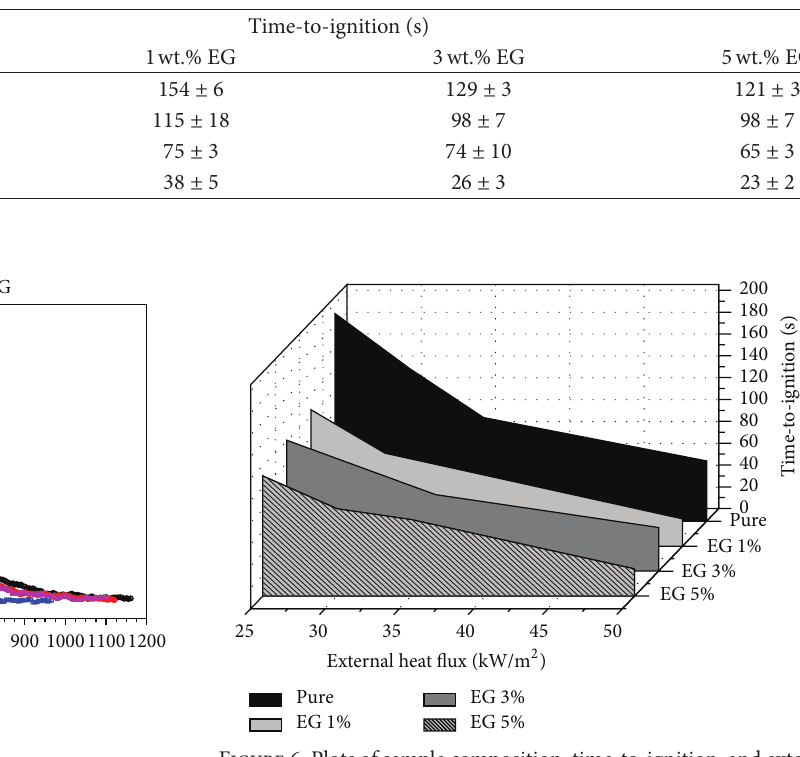
Figure 4: HRR profile epoxy-3 wt.% EG subjected to different exter- nal heat fluxes.